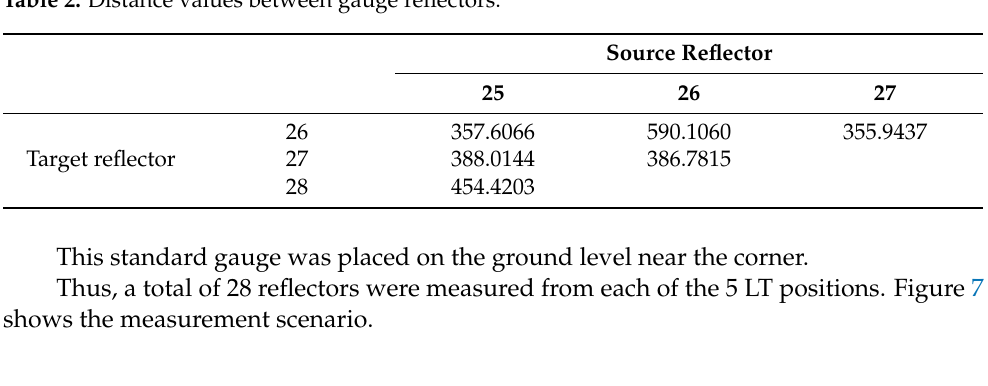
Table 2. Distance values between gauge reflectors.